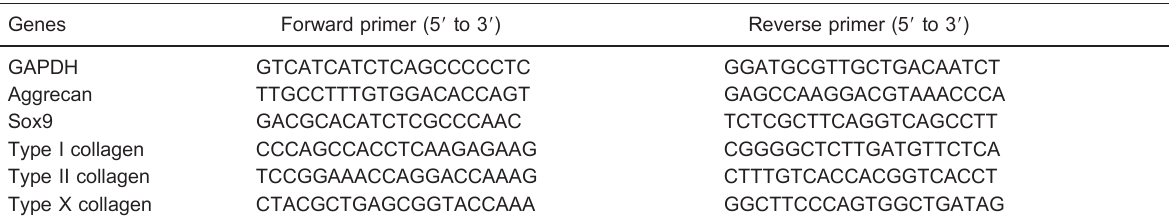
Table 1. Genes and primer design for quantitative real-time polymerase chain reaction analysis.